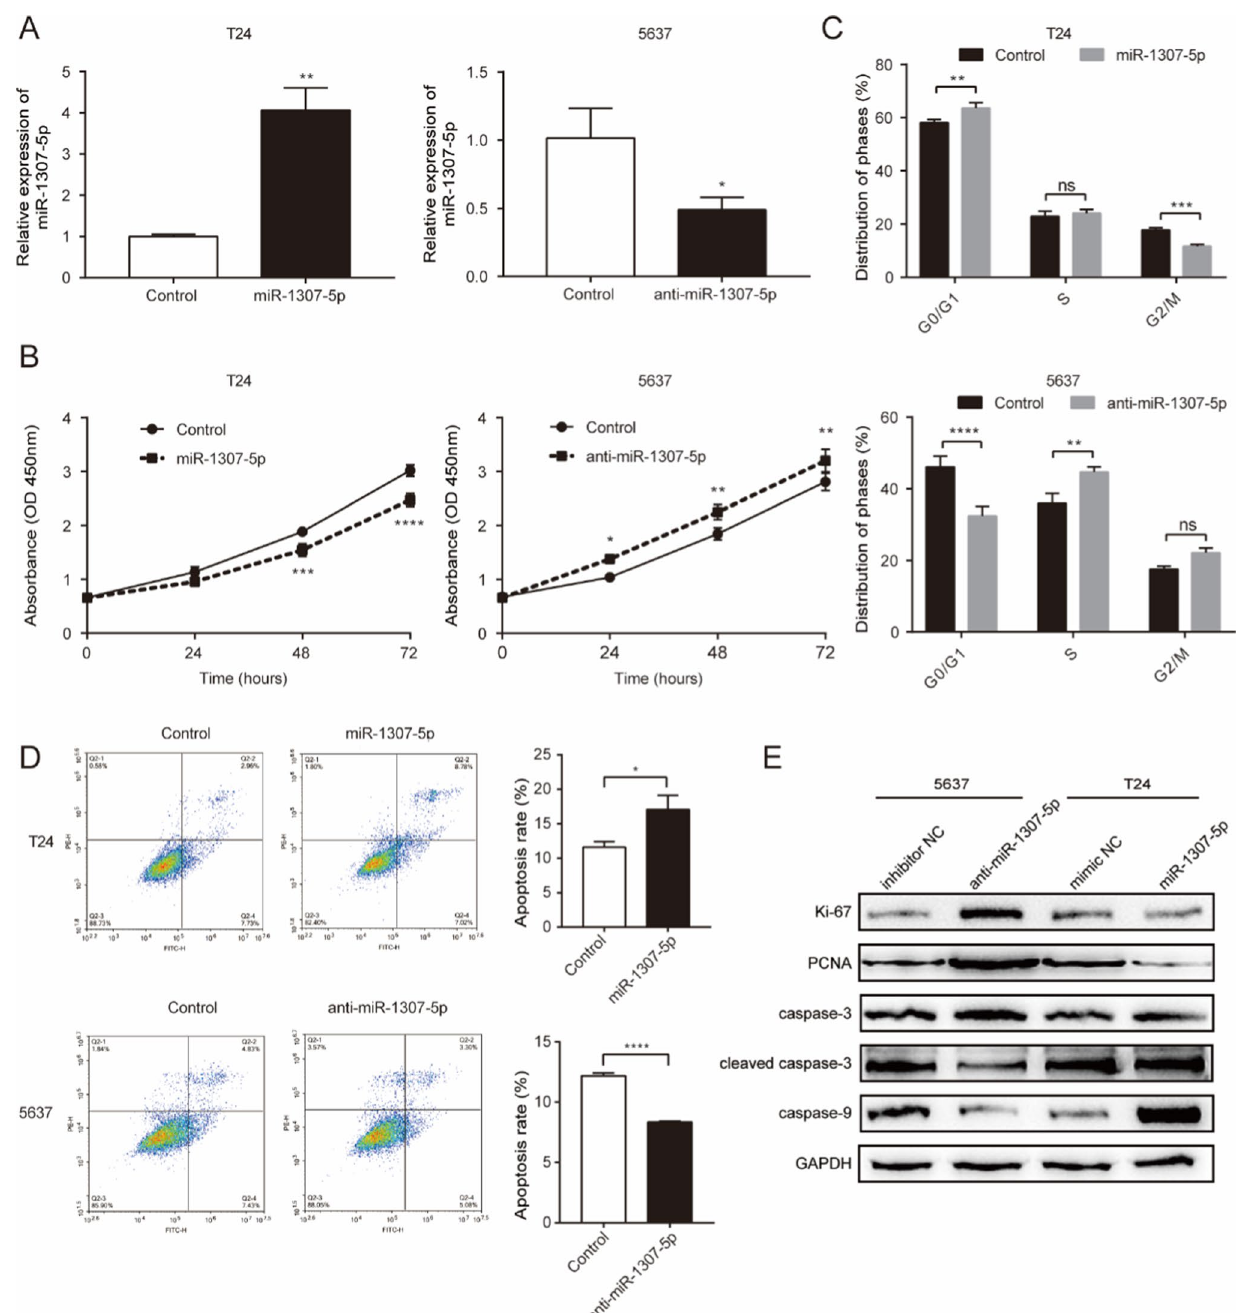
Fig. 2 miR-1307-5p inhibits cell proliferation and cell cycle progression and elicits cell apoptosis of bladder cancer cells in vitro. A Expression of miR-1307-5p in T24 and 5637 cells that were transfected with indicated vectors was determined by RT–qPCR. B CCK-8 assay was per- formed on cell proliferation upon transfection with miR-1307-5p mimics or inhibitor. C Flow cytometry assay with PI staining was performed on cell cycle. D Flow cytometry assay with Annexin V and PI staining was performed on cell apoptosis. E Expression of proliferation and apoptosis markers following miR-1307-5p stable overexpression or inhibition. *p < 0.05; **p < 0.01; ***p < 0.001; ****p < 0.0001; ns, no signifi- cance. Data depicts the mean ± standard deviation and are representative of three independent